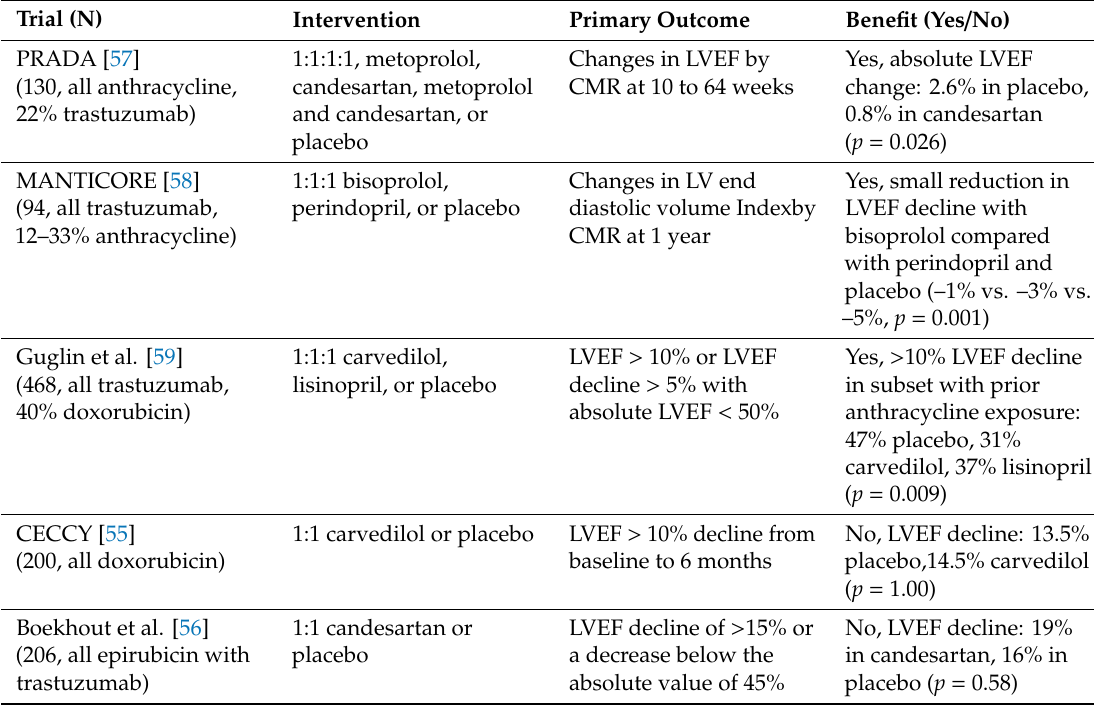
Table 1. Primary cardiotoxicity prevention trials in patients with breast